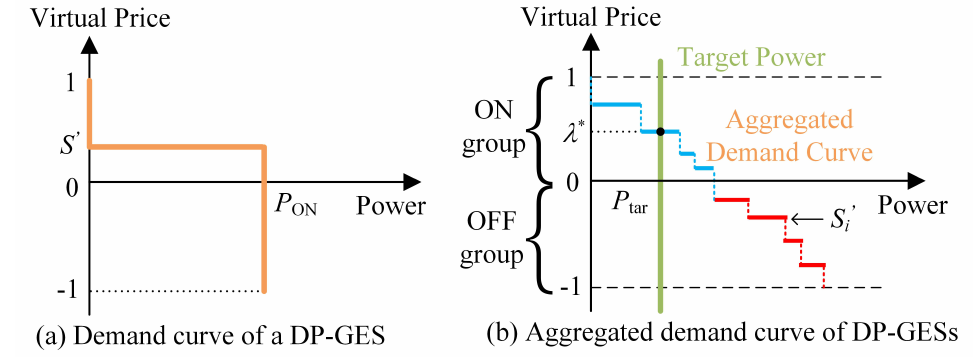
Figure 3. Demand curve of a discrete power